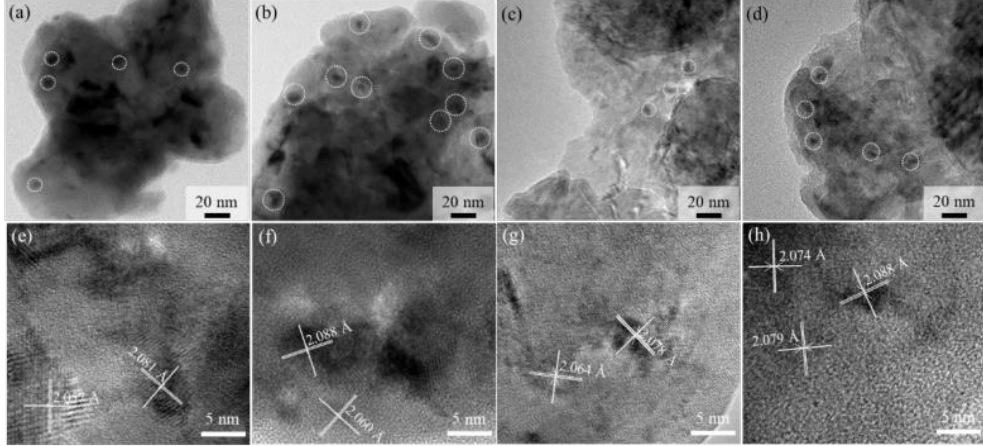
Figure 5. TEM images of porous Fe20Cr5Al after aging for 100 h ( a , e ) and 500 h ( b , f ) as well as Fe10Cr20Al after aging for 100 h ( c , g ) and 500 h ( d , h ).